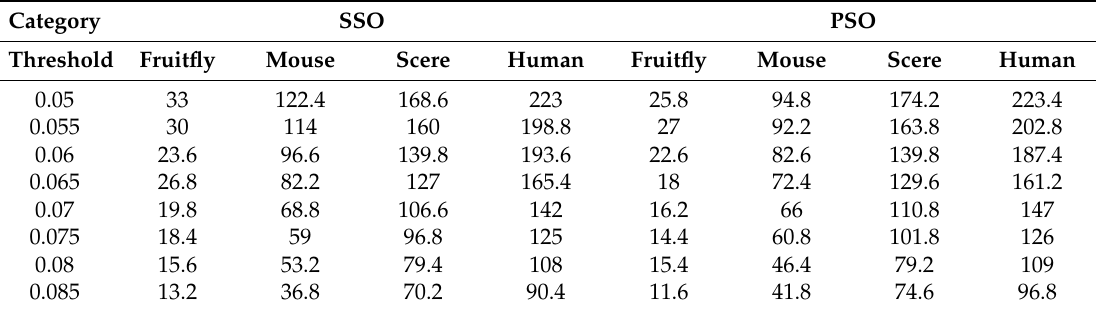
Table 5. Change of module number for PSO and SSO